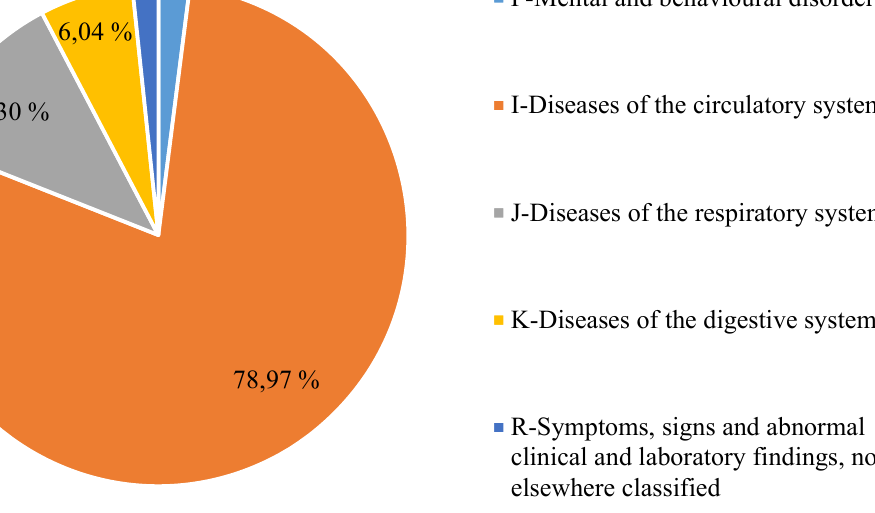
Fig. 2. Analysis of the structure of medicinal prescriptions (specific weight, %) in accordance with the first level of